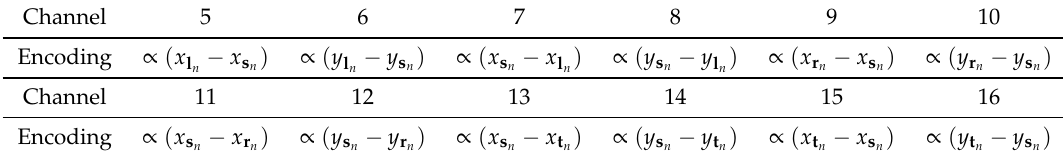
Table 2. Channels 5–16 of the image-space representation used to represent pig locations and orientations. Pairs of neighboring channels corresponds to the x and y offset between neighboring parts. Overall, these 12 channels represent bidirectional vectors linking three pairs of body parts.